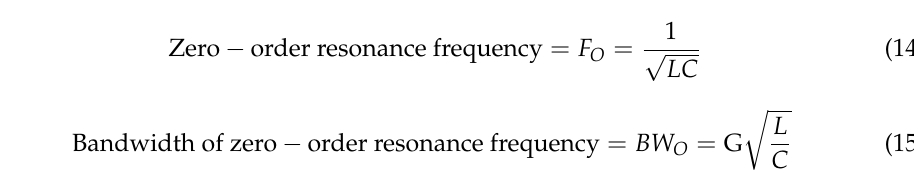
Figure 5. Schematics of the antenna in [43] with metamaterial and return loss. Reprinted from Ref. [43]. 2.2. Gain Improvement Overlapping between waves leads to interference, in such a way that if two waves with the same frequency, amplitude, and polarization but different phases are propagated in a medium in the z-direction, interference takes place. To enhance gain, this interference must be avoided to obtain a resultant wave with the same phase [25]. Consider two waves with electric fields of: